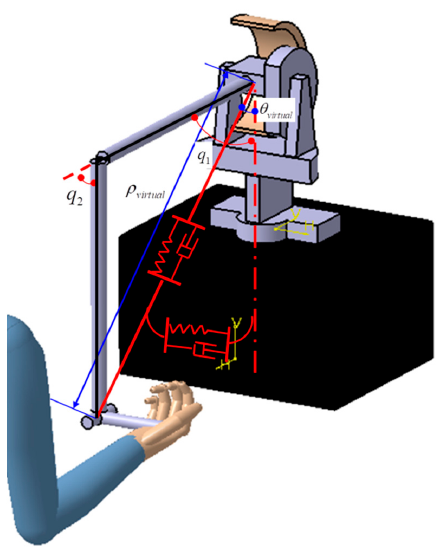
Figure 4. Schematic of the haptic device with virtual stiffness and damping.